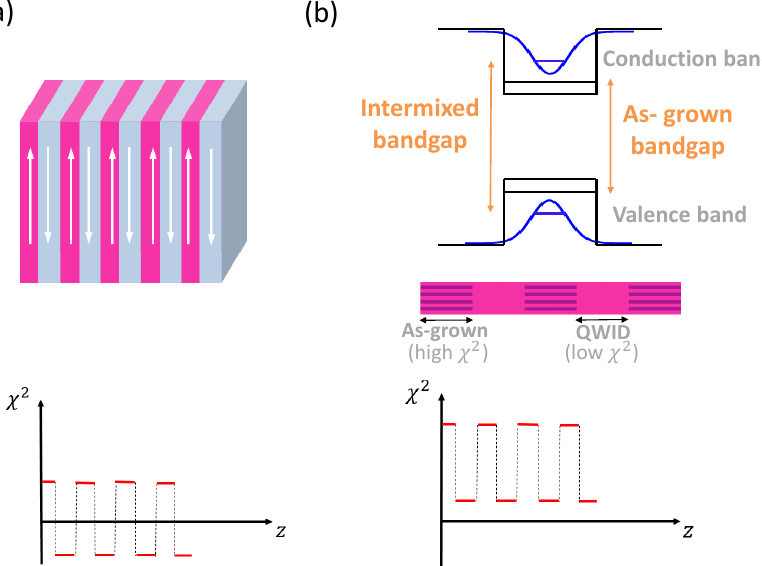
Figure 9. ( a ) The top part shows a schematic of a PDI QPM structure. The crystalline orientation is periodically altered with respect to <001> axis. The sign of χ ( 2 ) is, consequently, flipped, as schemat- ically shown in the bottom part. ( b ) Top: energy-band diagram of GaAs/AlGaAs quantum well, as-grown and intermixed. The process of QWI results in an increase in the energy gap compared to that of an as-grown structure, which results in a decrease in the value of χ ( 2 ) . The drawing in the middle shows the longitudinal cross-section of a PDD waveguide having as-grown and QWI domains (QWID). The bottom portion schematically shows the impact of the PDD through QWI on the values of χ ( 2 ) : it becomes periodically suppressed in the QWID